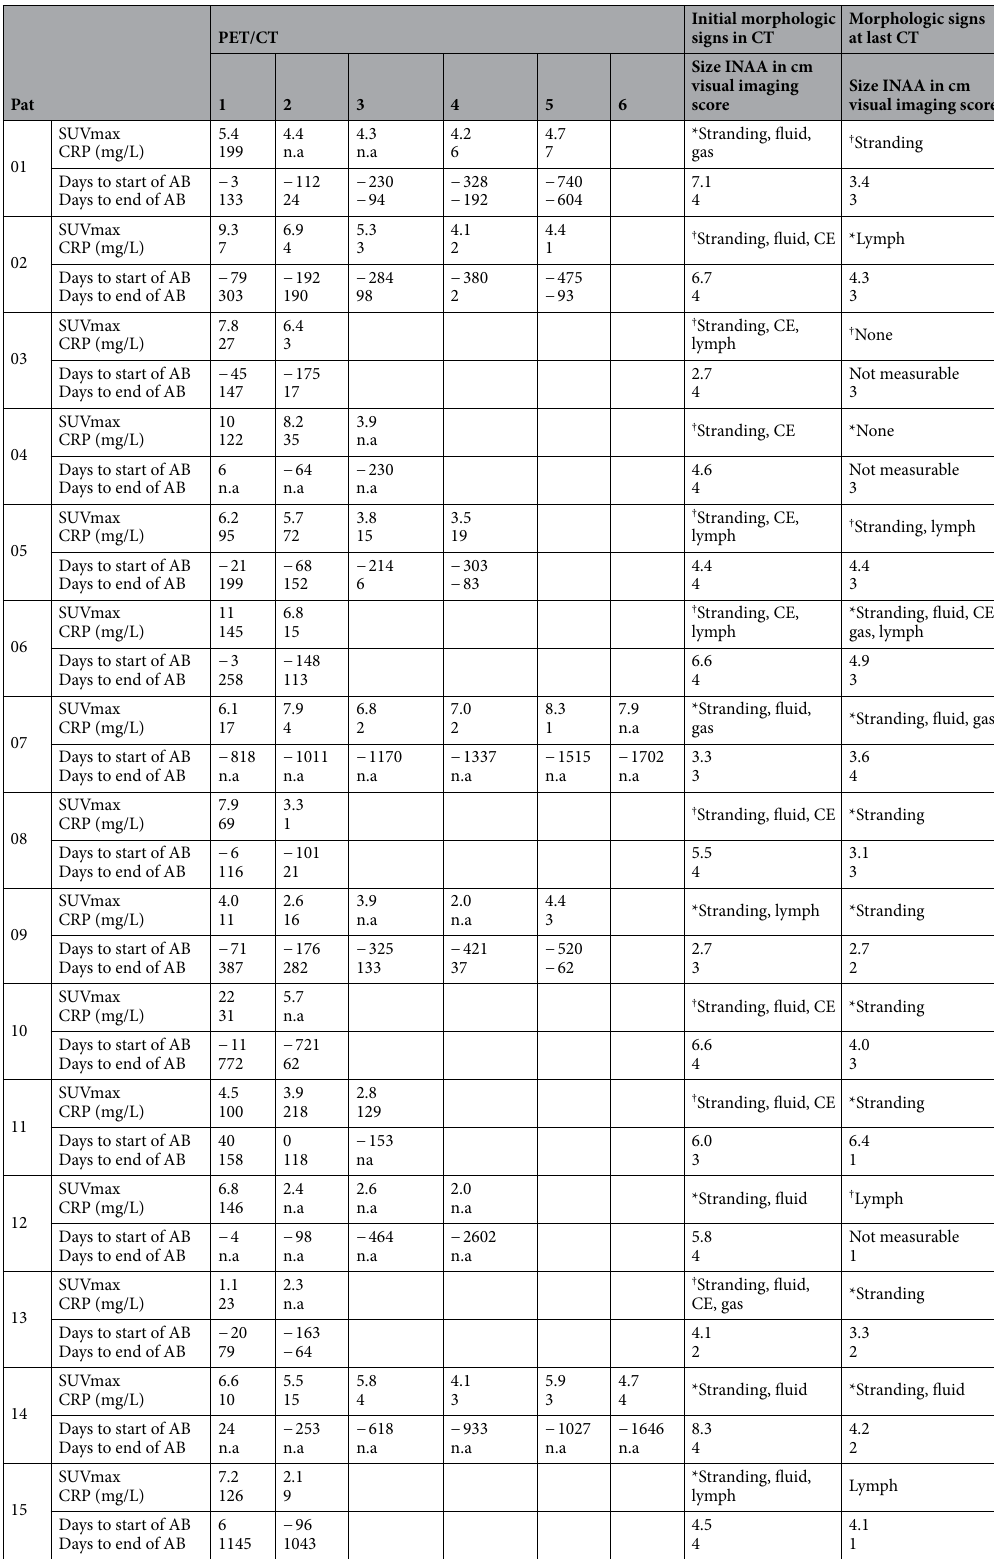
Table 3. Patient demographics, follow-up PET/CT and CT findings of the final study population in patients with proven infective native aortic aneurysms. Pat: Patient number; AB: antimicrobial treatment; n.a.: not applicable; stranding: fat stranding; fluid: fluid collection; CE: contrast enhancement, gas: gas formation; lymph.: lymph adenopathy. *Non-enhanced CT; † contrast-enhanced